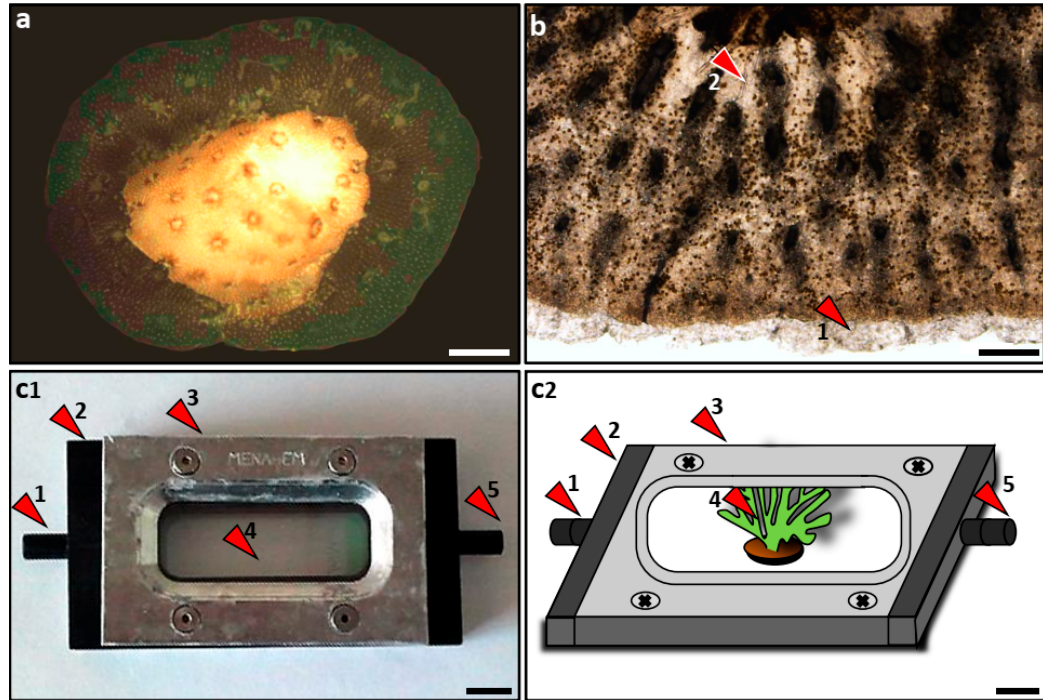
Figure 1. ( a ). An established nubbin (lateral skeleton preparative; LSP) assay, with the lateral extension on the substratum (a glass slide). ( b ) RGB image of the edge of the spreading tissue ( × 40), with newly formed noncalcified tissue (1) and zooxanthellae (2); age of the nubbin: 60 days. ( c1 ), ( c2 ): A photograph (c1) and illustration (c2) of the flow-through “coral chamber”, with the inlet (arrowhead 1), the central plastic box (arrowhead 2), the top sealing metal plate (arrowhead 3), the top cover glass slide (arrowhead 4) with the LSP below and the outlet (arrowhead 5). Scale bars: a = 2 mm; b = 0.2 mm; c1, c2 = 1 cm.